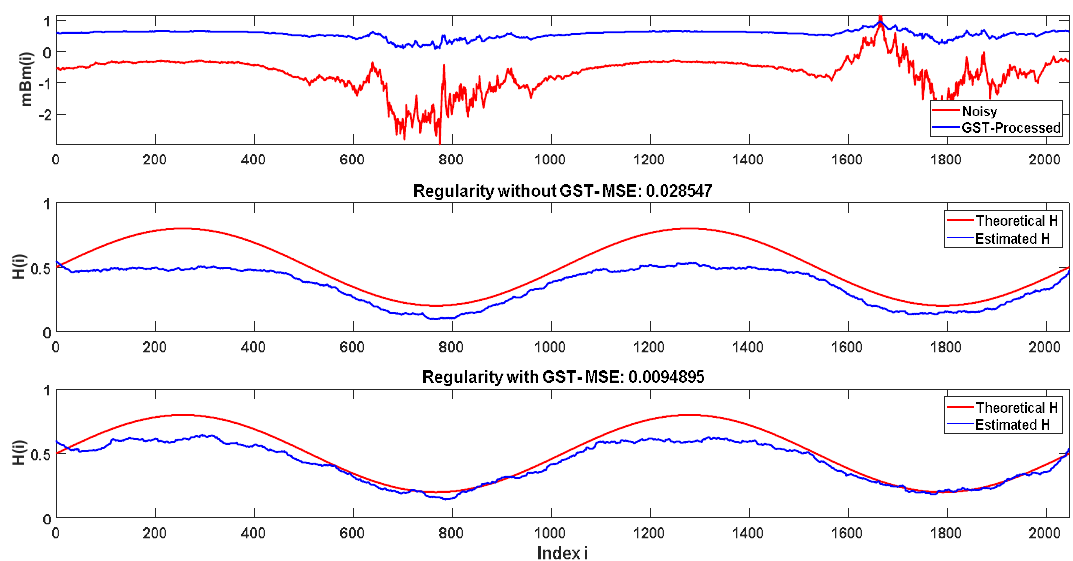
Figure 4. Results obtained from a realization of mBm path simulated with a periodic Hölder function H ( t ) (SNR = 40). This figure consists of three panels, described as follows. The first panel presents the noisy mBm paths (in red) and the standardized and processed by GST (in blue), the second panel shows the local Hölder exponent function estimated from the noisy mBm path (blue line) and the theoretical Hölder function (red line), and the third panel illustrates the local Hölder exponent function estimated from the mBm path processed by GST (blue line) and the theoretical Hölder function (red line).